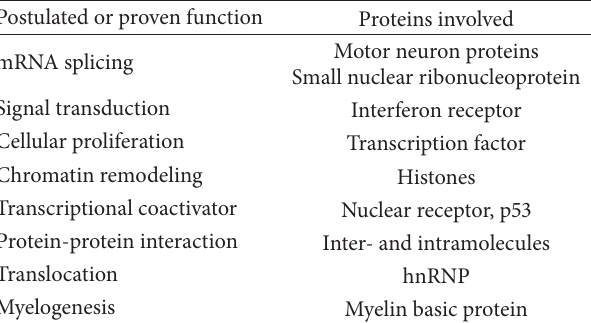
Table 1: The biological function of methylated